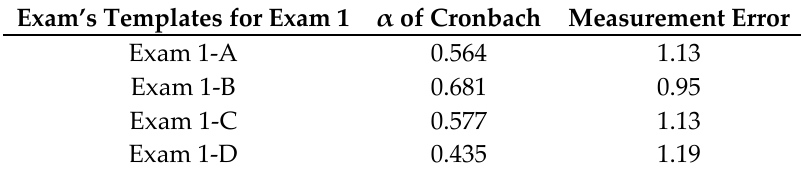
Table 5. Multiple choice exam’s quality.